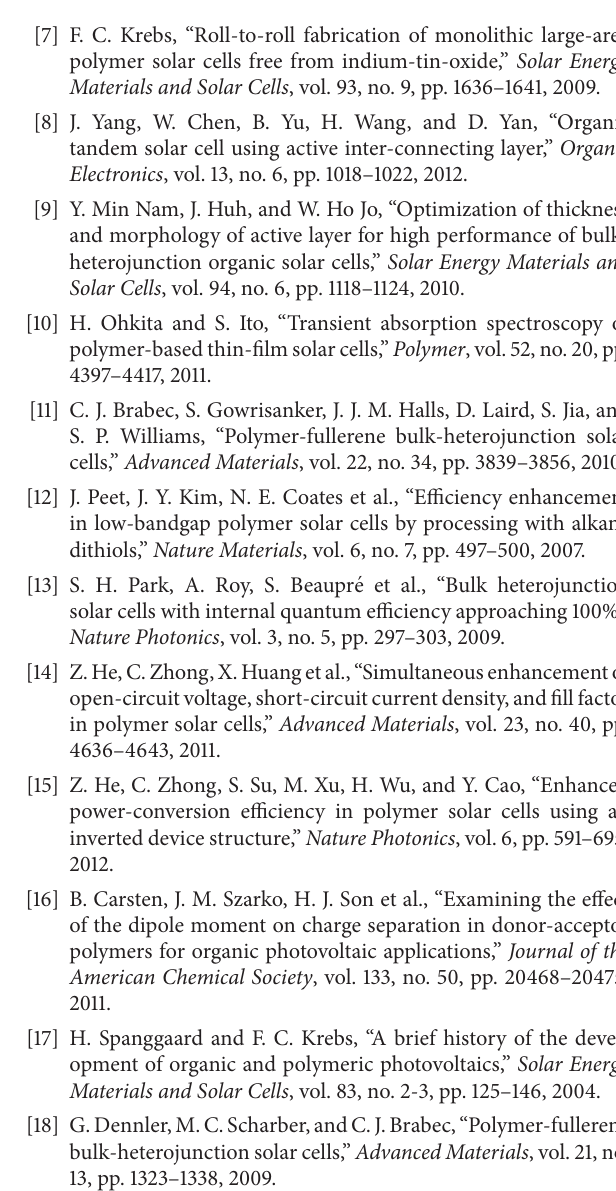
Table 1: Photovoltaic parameters of the OSC devices with different solvents and different PCDTBT:PC BM blend ratios. 71 Solvents Blend ratio Thickness (nm) 𝐽 (mA/cm 2 ) 𝑉 (V) FF 𝜂 (%) sc oc 1: 3 92 4.39 0.90 0.48 1.89 1: 4 88 5.78 0.91 0.47 2.49 Chloroform 1: 5 86 5.09 0.90 0.56 2.55 1: 6 80 3.55 0.91 0.55 1.77 1: 3 94 5.94 0.91 0.43 2.33 1: 4 92 5.55 0.93 0.56 2.91 Chlorobenzene 1: 5 88 5.72 0.89 0.55 2.79 1: 6 83 4.92 0.91 0.56 2.53 1: 3 93 7.60 0.89 0.53 3.60 1: 4 90 8.41 0.90 0.55 4.15 O-dichlorobenzene 1: 5 85 7.36 0.89 0.55 3.56 1: 6 78 7.19 0.87 0.55